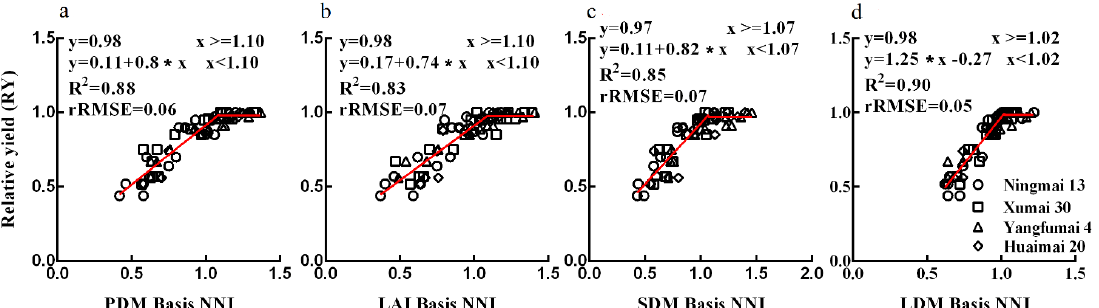
Figure 9. Relationships between different basis nitrogen nutrition index (NNI) values and relative yield (RY) ( a – d means different indicators based NNI values, a is PDM basis, b means LAI basis, c represents SDM basis, d is LDM basis).